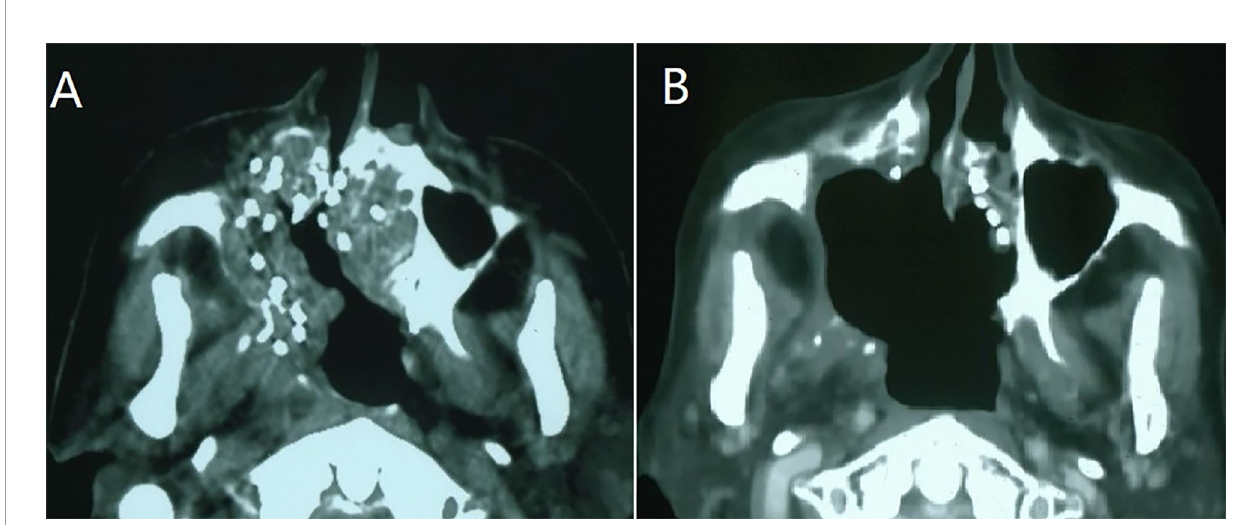
FIGURE 1 | A case of recurrent maxillary sinus squamous carcinoma following surgery and adjuvant radiotherapy. (A) CT-guided I 125 seeds were implanted as a salvage treatment; (B) : Three months after the seed implantation, partial response was